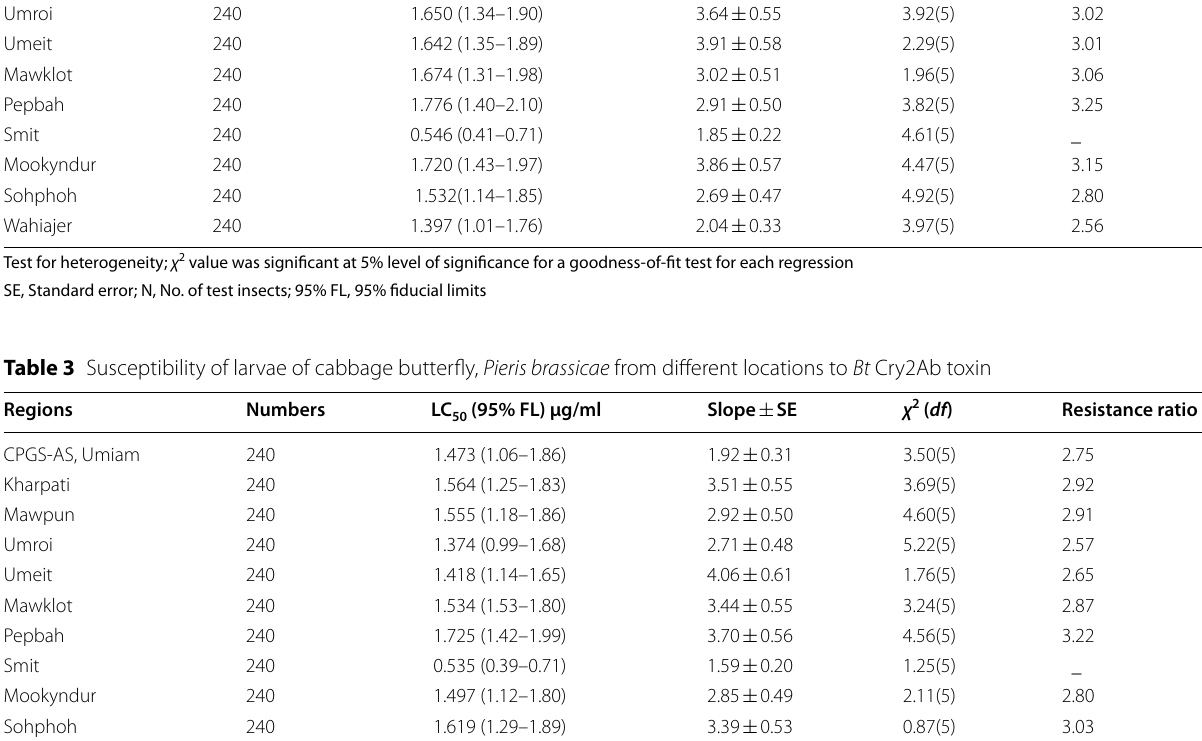
Test for heterogeneity; χ 2 value was significant at 5% level of significance for a goodness-of-fit test for each regression SE, Standard error; N, No. of test insects; 95% FL, 95% fiducial